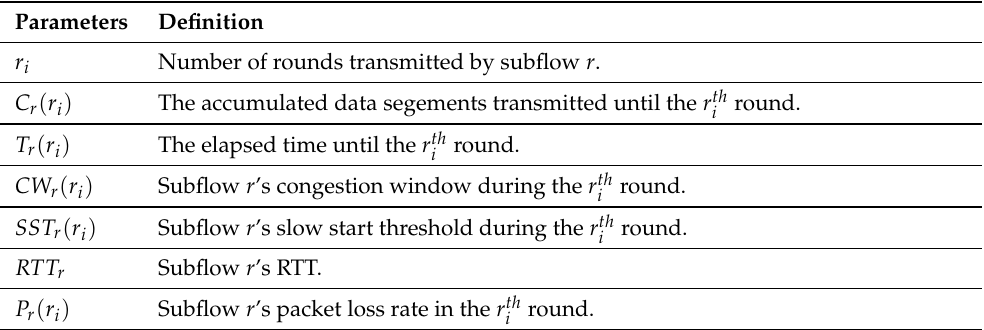
Table 1. List of transfer model’s